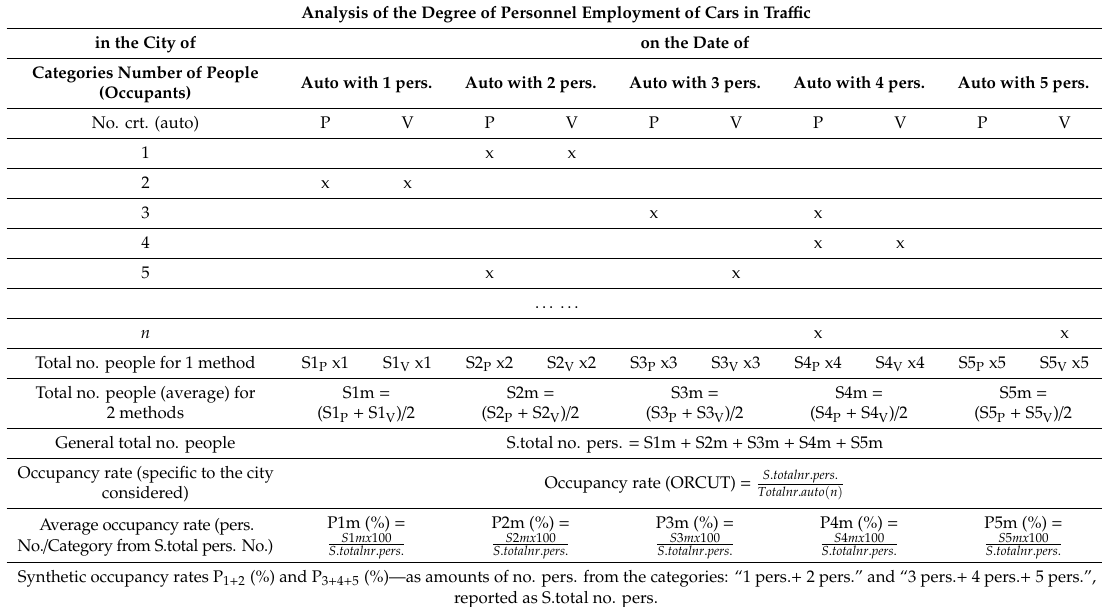
Table 2. Analysis of the degree of personnel employment of cars in tra ffi